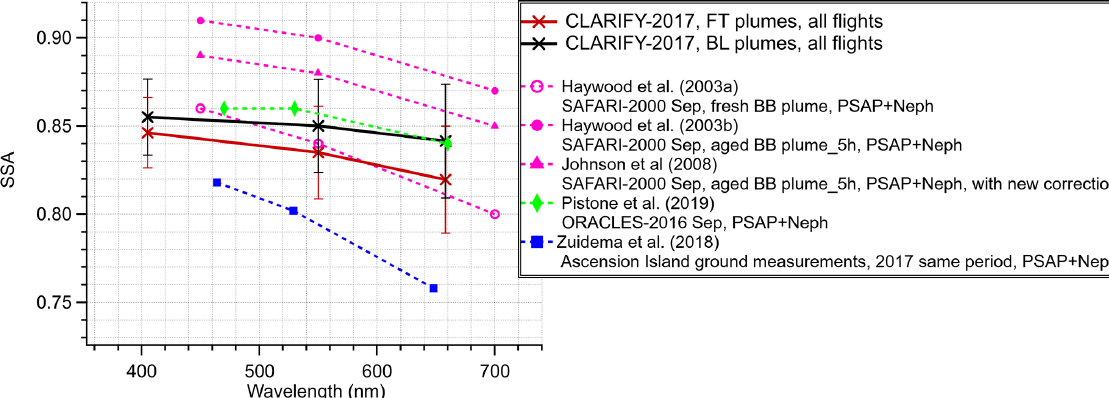
Figure 8. Wavelength dependence of the average SSA of FT and BL BBA for all flights used in this study. The markers and lines represent the mean value and standard deviation. The average SSAs from previous studies in this region are shown for comparison. (Note that the PSAP only measured absorption at 567nm in SAFARI 2000; assumptions about the wavelength dependence of absorption coefficient were made to estimate absorption at 450 and 700nm, which was then used to calculate the